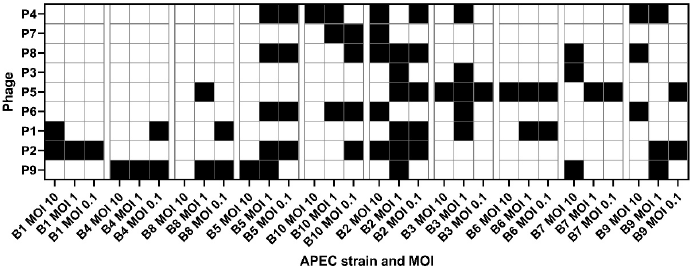
Figure 9. Overview of the discrepancies of the groupings of the phage–APEC–MOI combination replicates. P = phage. B = bacterium. MOI = multiplicity of infection. White = no discrepancies. Black = one or more discrepancies. Sixty-nine technical replicates were included for each combination. Combinations with P10–18 were not included, as no discrepancies were detected.